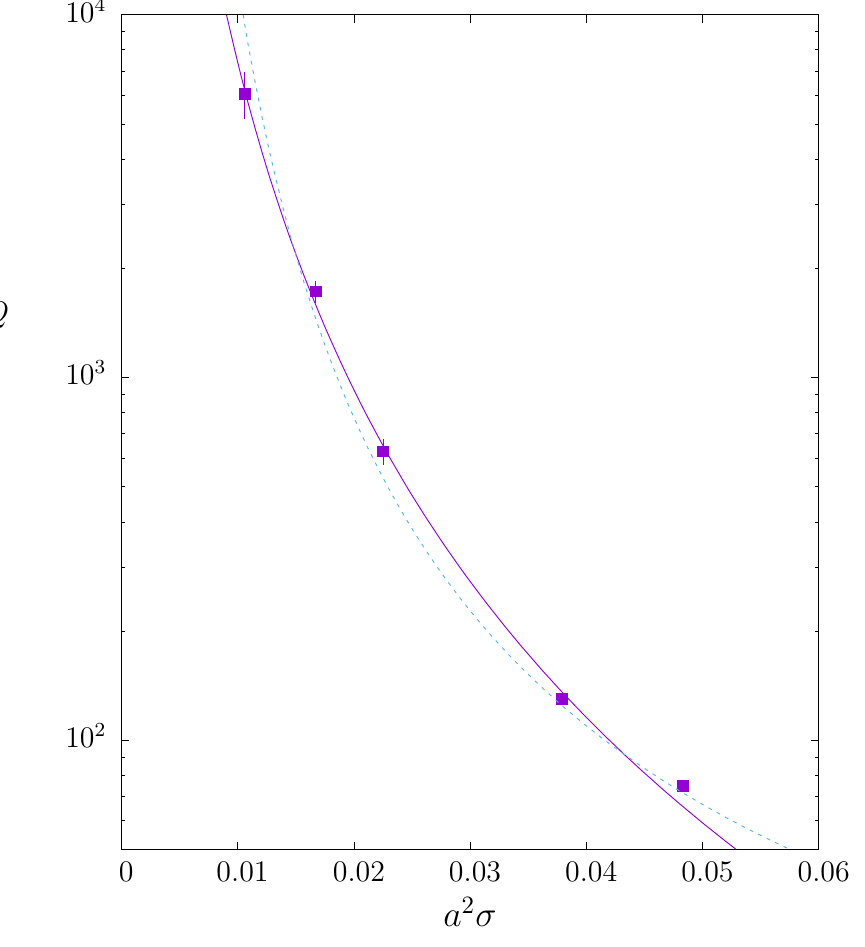
Figure 32 . Correlation length ξ Q for the SU(3) lattice topological charge defined by the relation h Q ( is ) Q ( is + ξ Q ) i / h Q 2 i = e − 1 where is and is + ξ Q label the number of MC sweeps. Solid line is √ √ ξ Q ∝ 1 / ( a σ ) 6 , dashed line is ξ Q ∝ exp { c/a σ } . Calculations are for β ∈ [5 . 99 , 6 . 50]